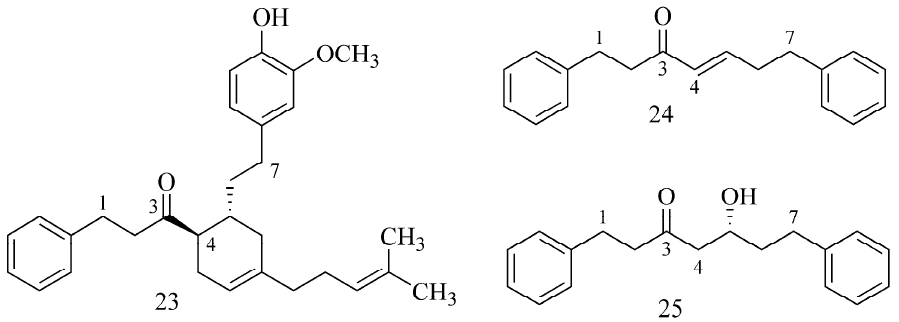
Figure 9. Chemical structures of ( − )-alpininoid B ( 23 ), (4 E )-1,7-diphenyl 4-hepten-3-one ( 24 ) and dihydroyashsbushiketol ( 25 ).